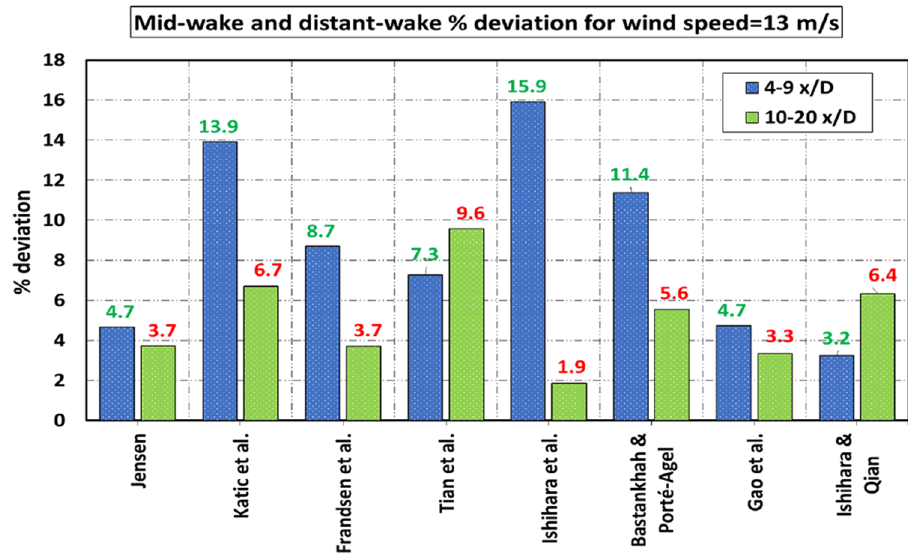
Fig. 8. Average percentage deviation of each wake model for upstream wind speed value equal to 13 m/s.